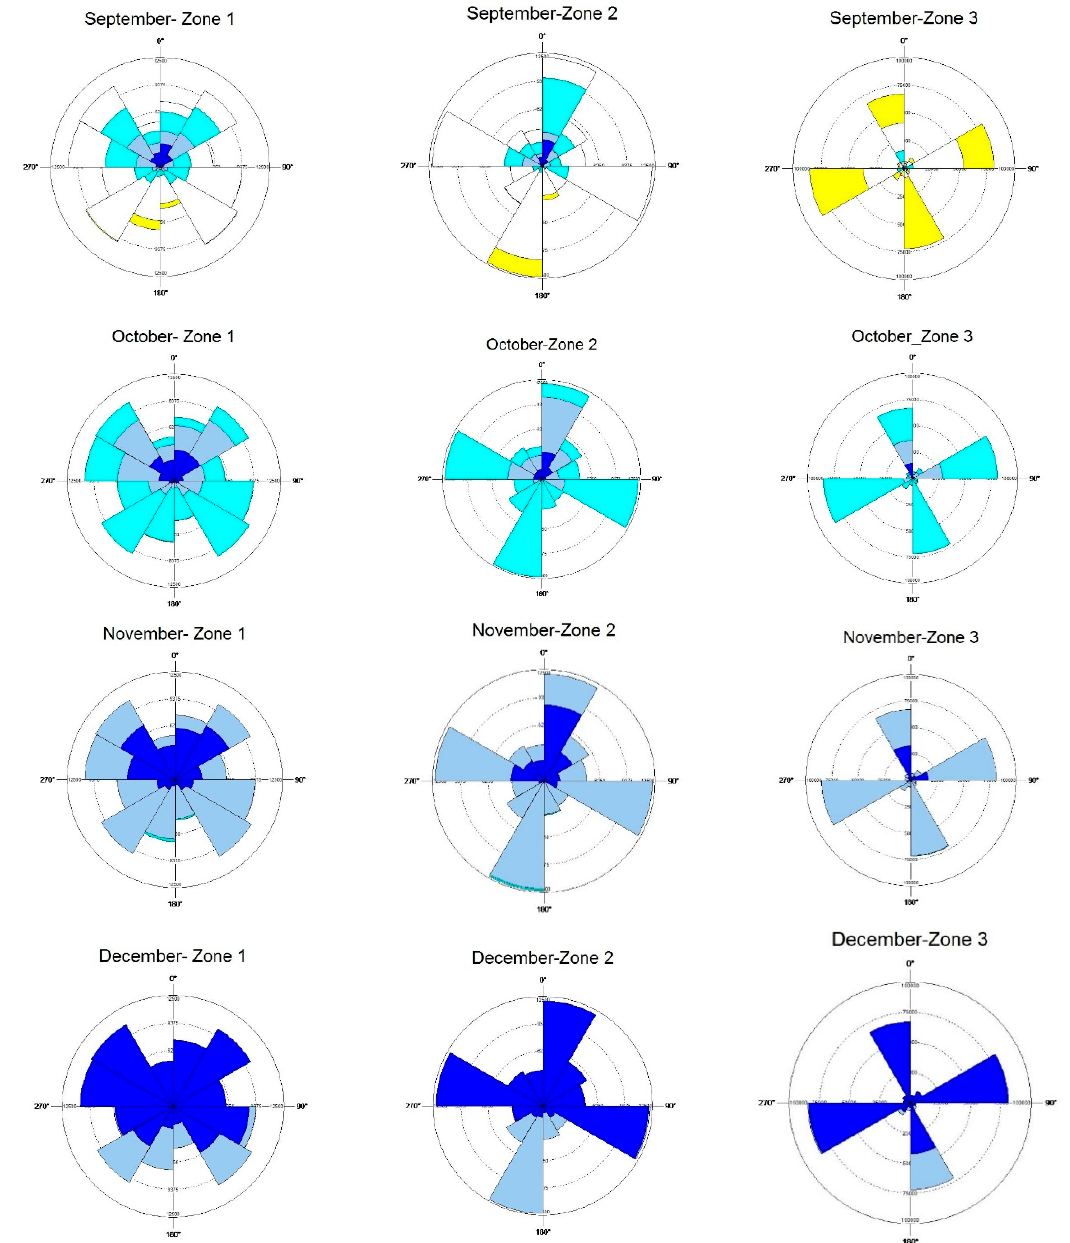
Figure 6. Two-variable circular histogram graphics of the three zones for every month of the year.